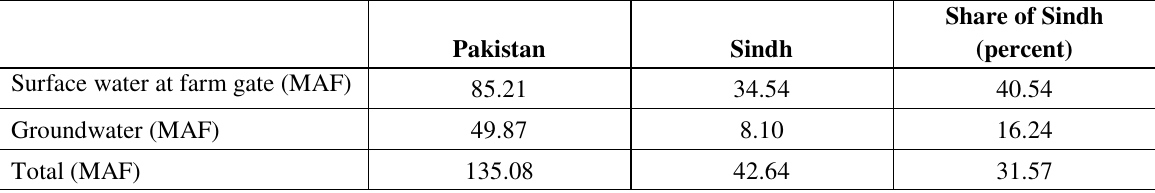
Table 3: Availability of Surface Water at Farm Gate and Groundwater per Year: Average during 2007-08 to